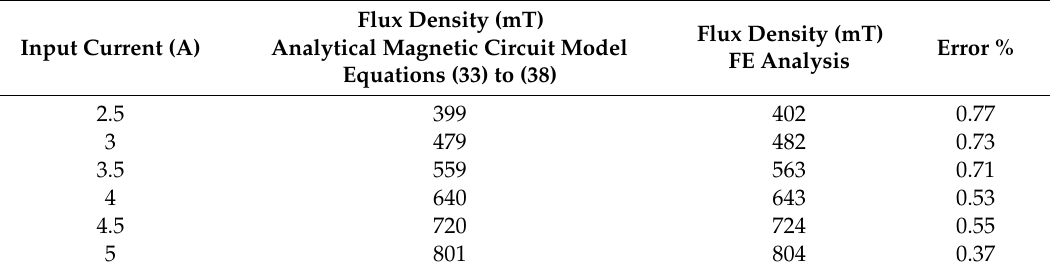
Table 1. Comparison of flux density values at the center of the air gap of the H-shaped electromagnet obtained by analytical magnetic circuit model (Equations (33) to (38)) and FE